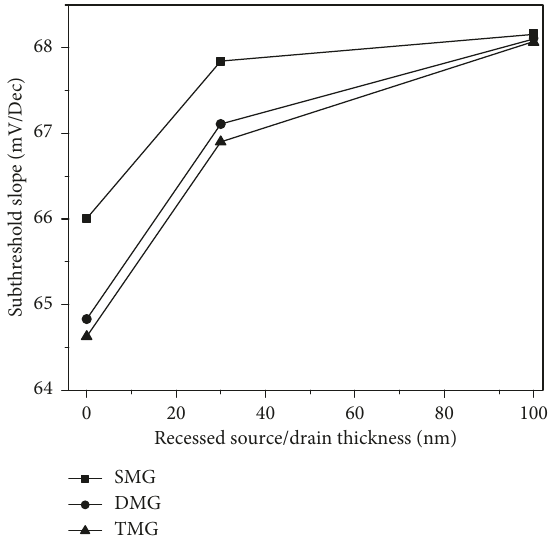
Figure 14: Subthreshold slope for SMG, DMG, and TMG Re-S/D SOI MOSFET versus Re-S/D thickness.